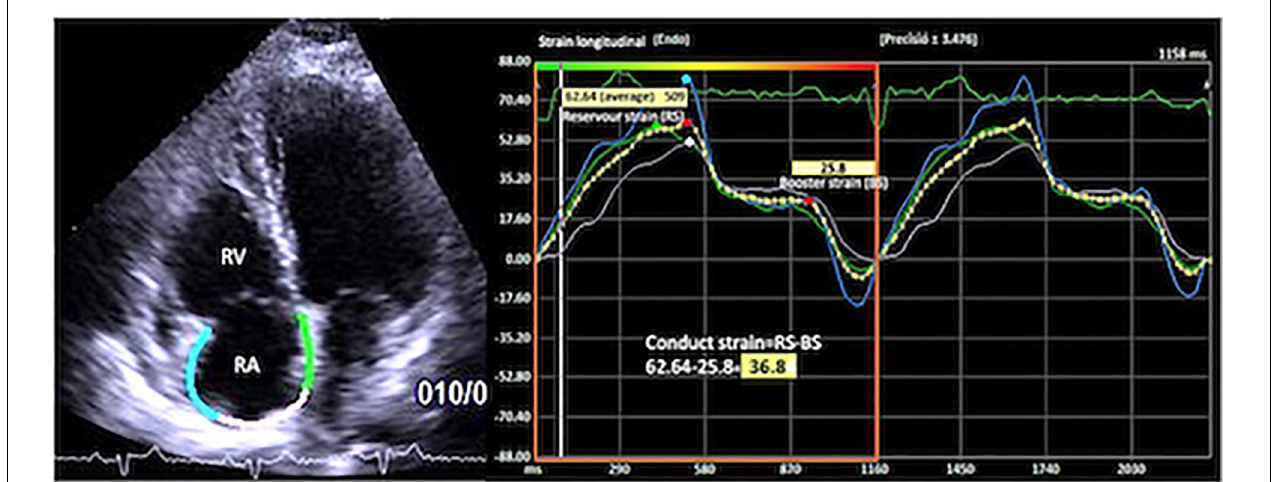
FIGURE 1 | Apical four-chamber view showing the right atrial global longitudinal strain (RA-GS) with the measurement of reservoir, conduit, and contractile strain phases.